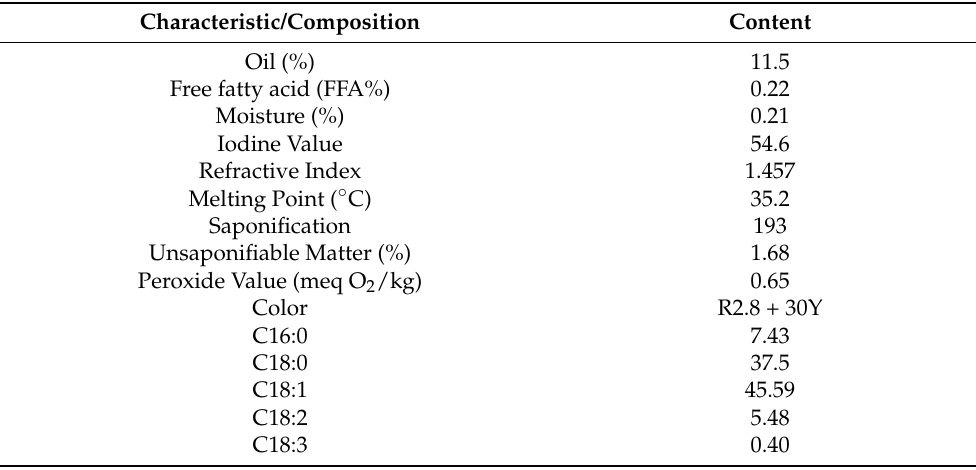
Table 2. Physical and chemical characteristics and composition of mango seed